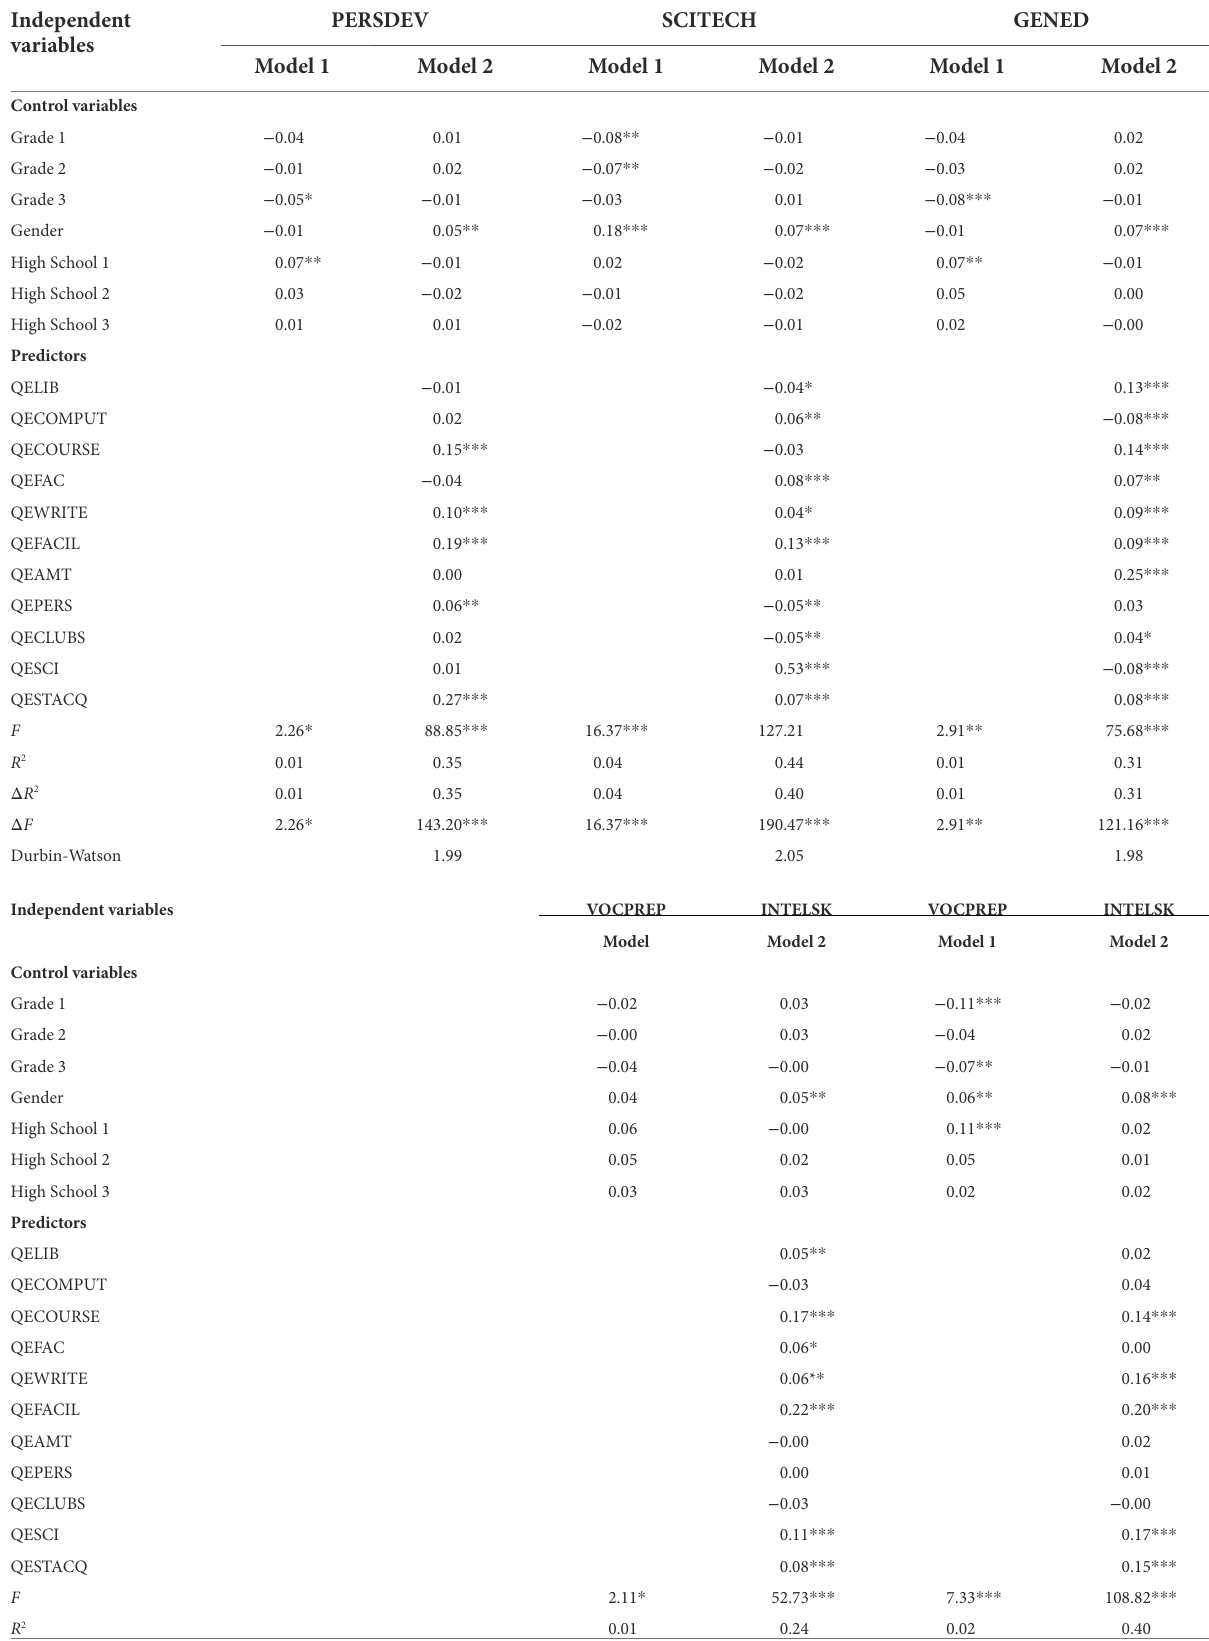
TABLE 4 Hierarchical linear regression of gains factors. Independent PERSDEV SCITECH GENED variables Model 1 Model